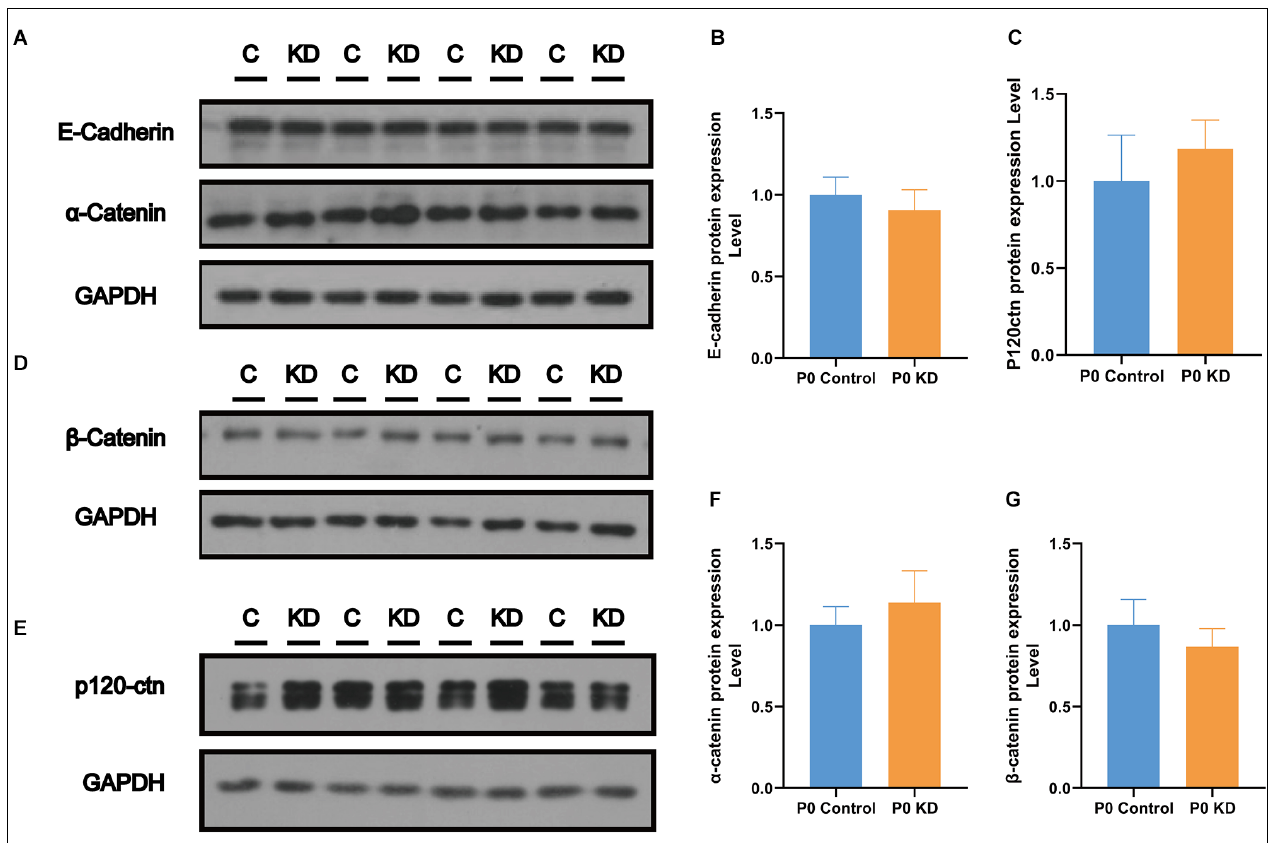
FIGURE 6 | No change was found in the protein expression level of the cadherin–catenin core complex. Protein expression level of E-cadherin, α -catenin (A) , β - catenin (D) , and p120-ctn (E) in P0 control and P0 KD groups. Comparison of relative E-cadherin (B) , p120ctn (C) , α -catenin (F) , and β -catenin (G) protein expression in P0 control and P0 KD groups. GAPDH was used as the